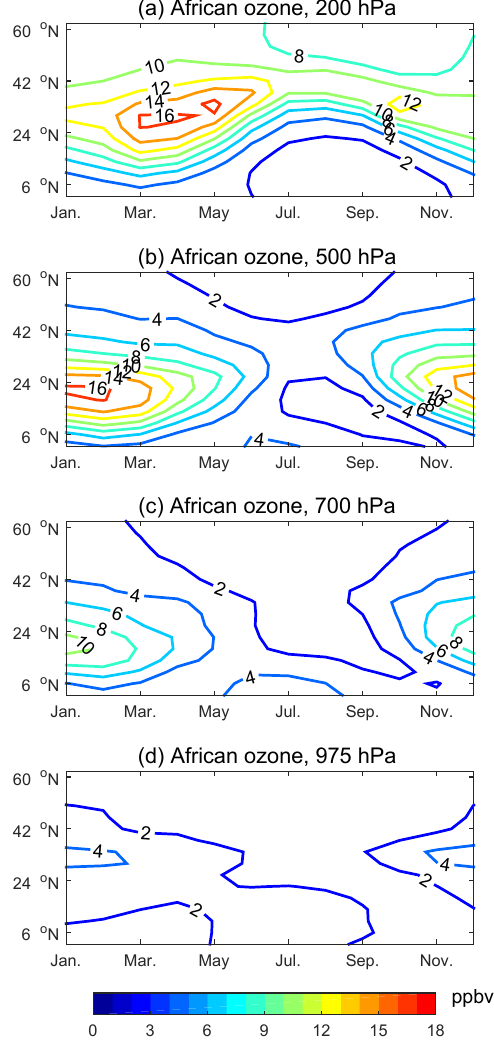
Figure 5. Seasonal variation of imported African ozone (in ppbv) over Asia varying with latitude at (a) 200hPa, (b) 500hPa, (c) 700hPa, and (d) 975hPa. The values are the 20-year means (1987–2006) from the GEOS-Chem simulation and averaged over 60–145 ◦